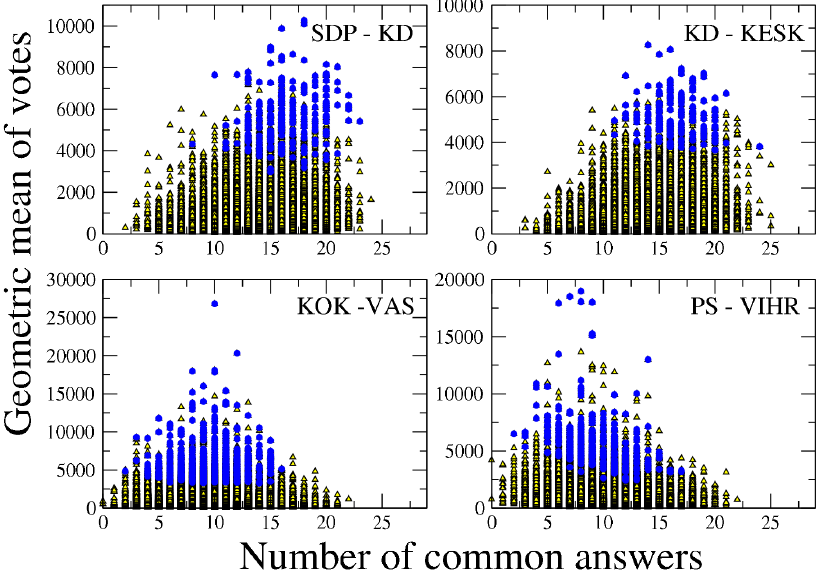
Figure 3. Scatter plot of votes VS number of common answers for candidates belonging to different parties. Scatter plot of the geometric mean of the votes obtained versus the number of common answers for pairs of candidates belonging to four pairs of parties. Each pair of candidates is formed by one candidate from one party and the other from a different party. The pairs of parties are: SPD-KD (top left), KD-KESK (top right), KOK-VAS (bottom left) and PS-VIHR (bottom right). Yellow triangles denote pairs of non elected candidates whereas blue circles denote pairs of candidates that have been elected.